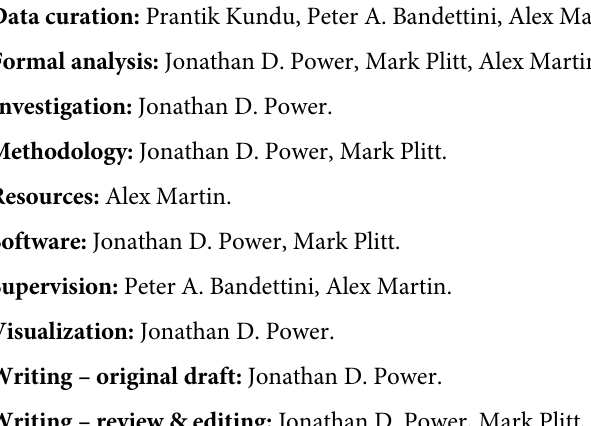
S6 Fig. Motion artifact is reduced in despiked data. As for Fig 5, but with all cohorts. The x- axis represents distance, spanning 0–180 mm. (TIFF) S7 Fig. QC:RSFC correlations are not systematically changed across processing strategies. As in Fig 6, but with all cohorts. The x-axis represents distance, spanning 0–180 mm. (TIFF) S1 Table. Mean and standard deviations in each dataset of the mean motion of all subjects. DS means despiked, TS means slice time